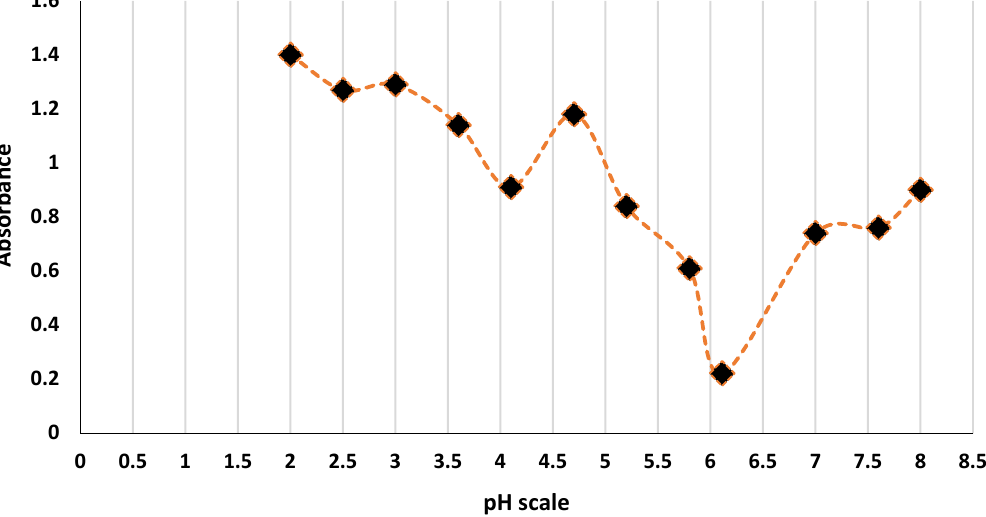
Figure 6. pH scale and its effect on the AgNPs@AG reaction medium.